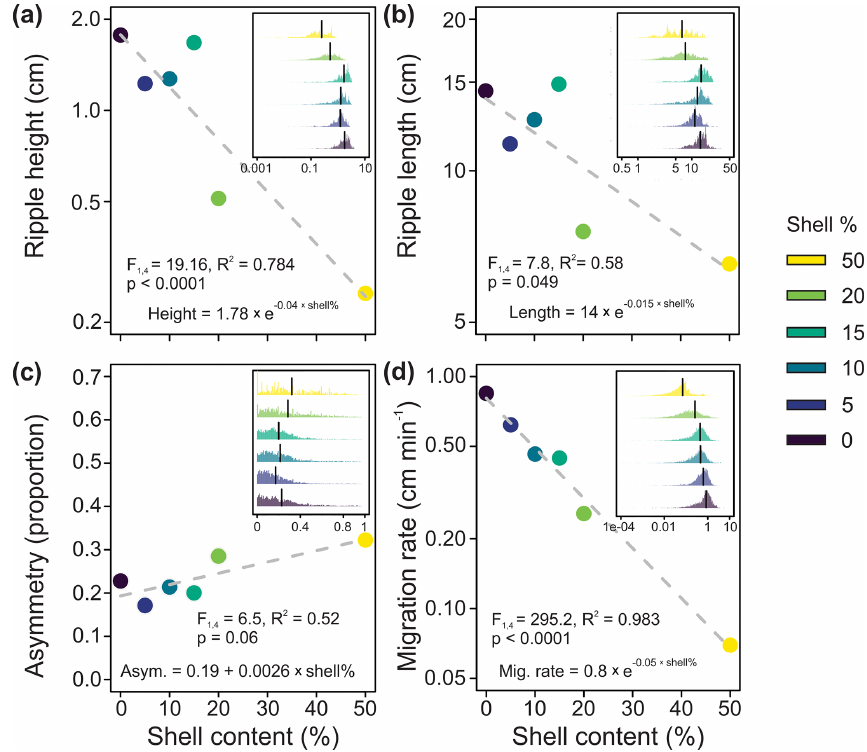
Figure 4. (a) Ripple height, (b) ripple length, (c) asymmetry and (d) migration rate, plotted against the shell content from the constant flow experimental runs ( n = 6). The y axis of the ripple height, length and migration are plotted on a log scale. The inset panels show the corresponding histograms for each ripple parameter, with the x axis values representing the y axis values of the respective regression plots. Vertical lines represent mean